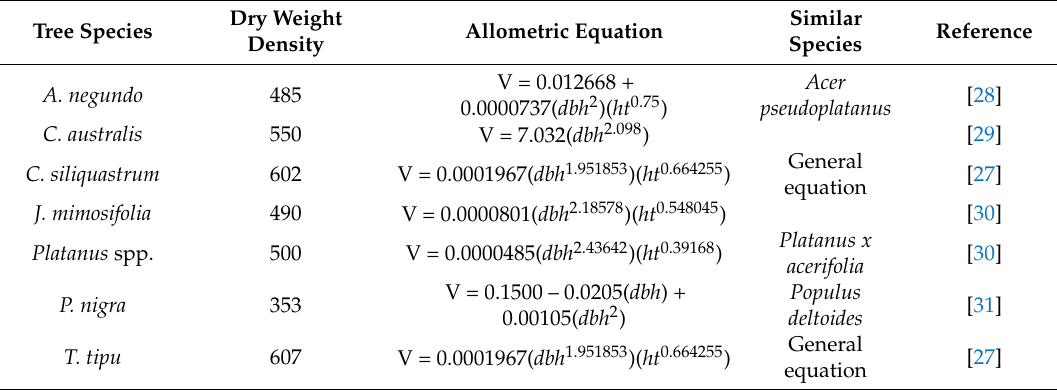
Table 3. Allometric equations used to compute volume (V) for each tree species and respective source reference. As input for the equations: dbh (cm) (except for the C. australis equation, where dbh (m)) and ht (m). Dry weight density for each tree species (kg/m 3